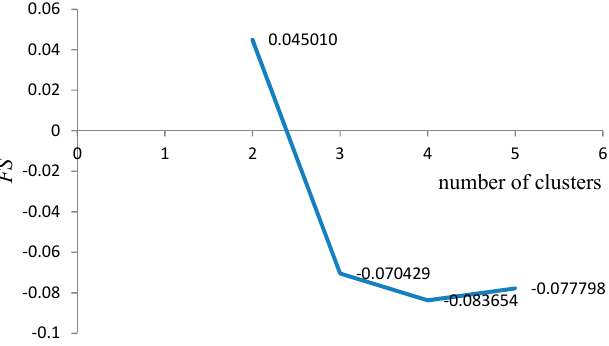
Figure 8. Graph of the Fukuyama-Sugeno validity functional for a (78 × 6) matrix.